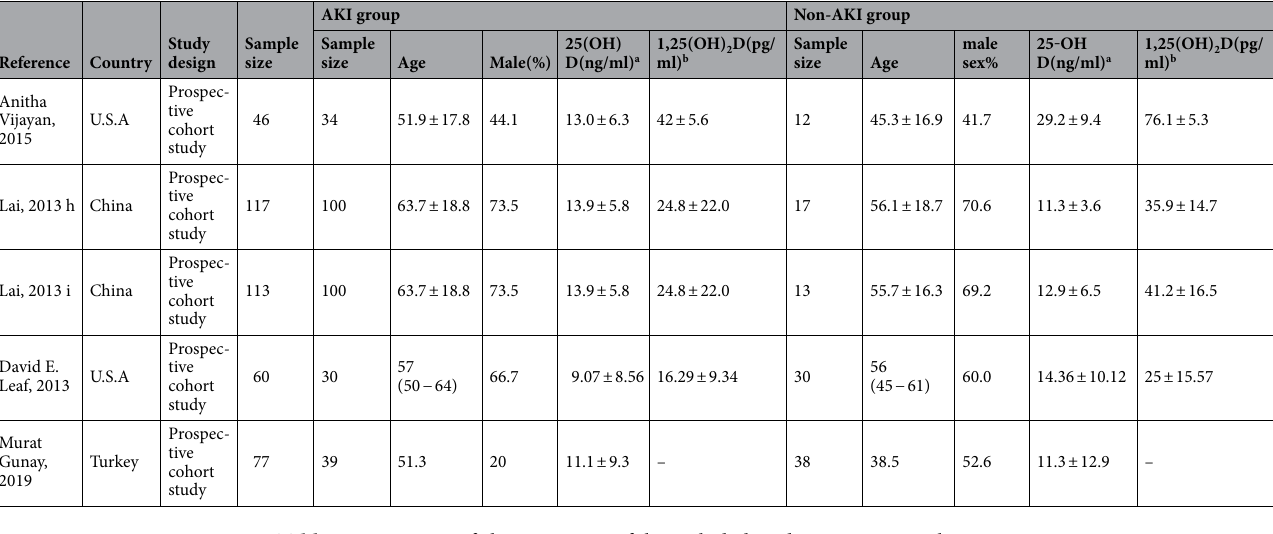
Table 2. Summary of characteristics of the included studies. *a p = 0.11; *b p = 0.02.